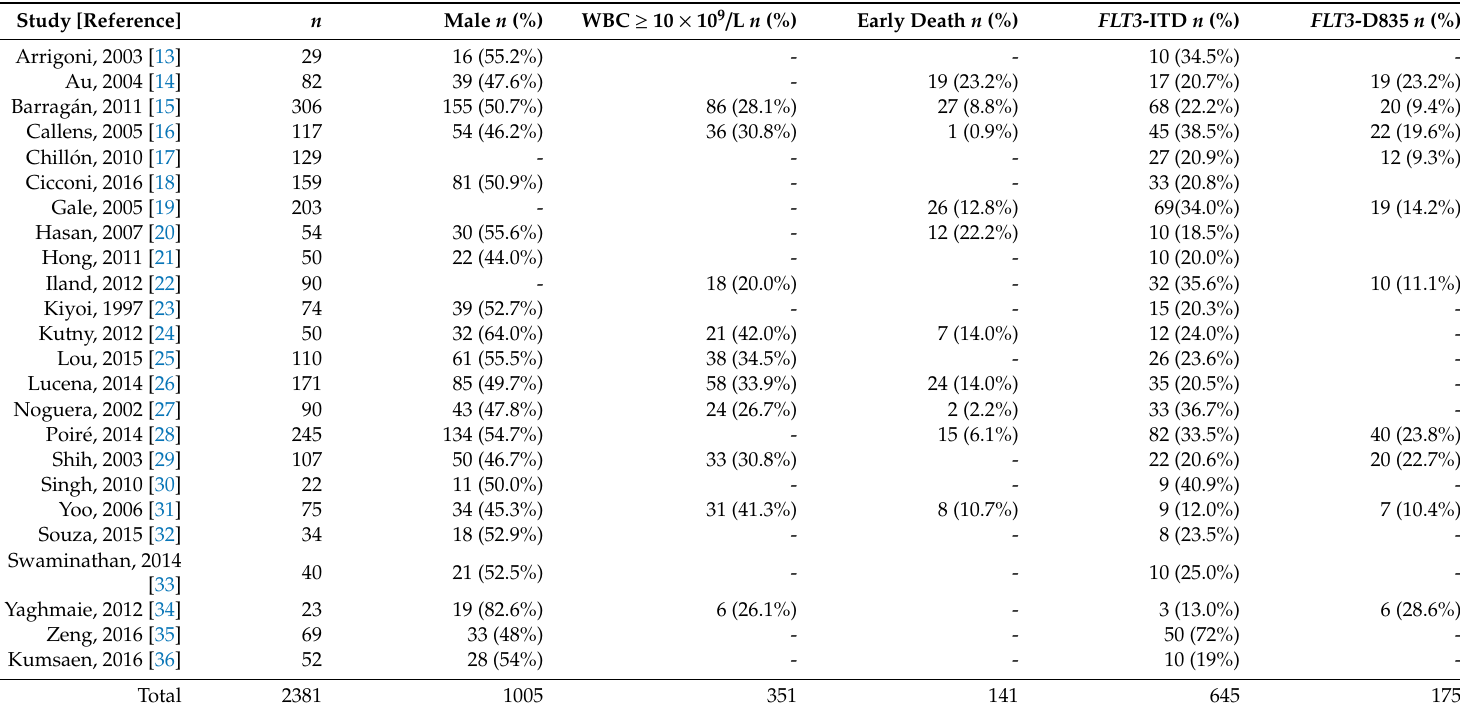
Table 1. Features of the studies included in this systematic